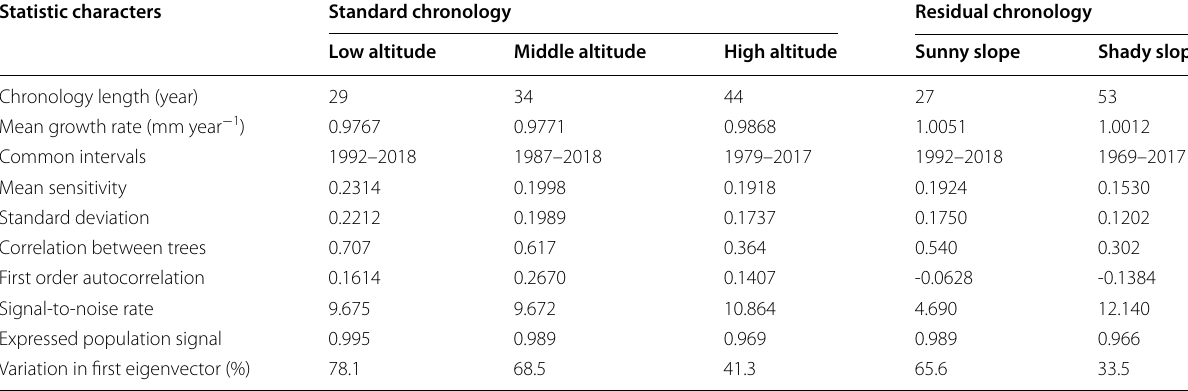
Table 2 Statistics of tree-ring width chronologies and common interval